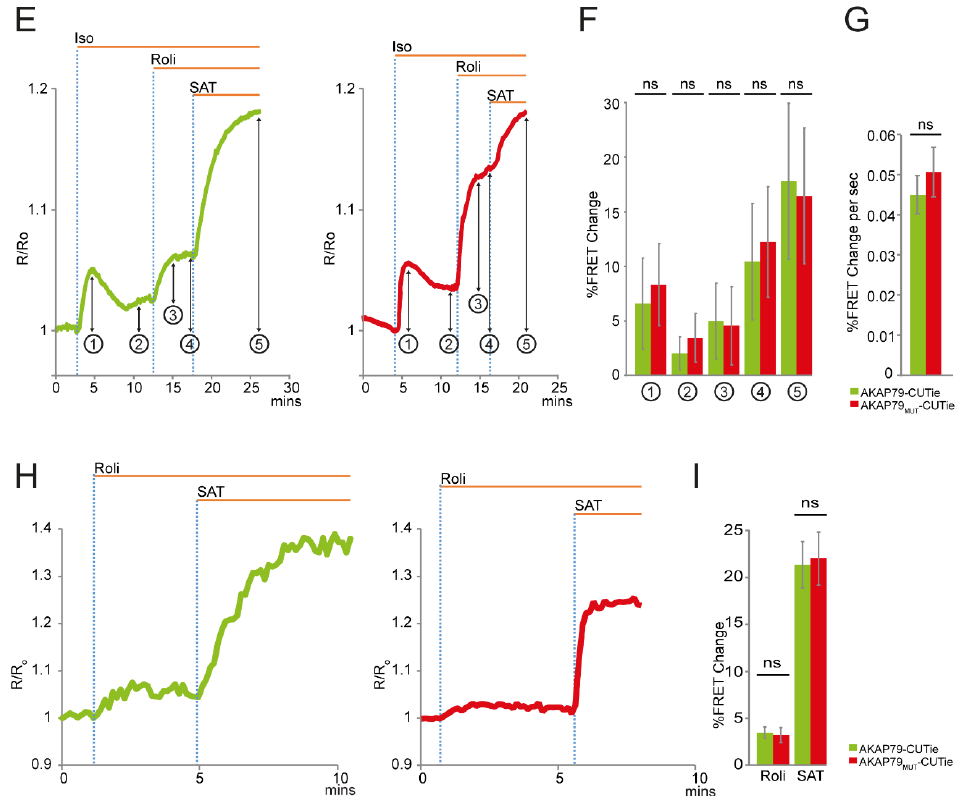
Figure 1. Effect on 3′–5′cyclic AMP (cAMP) readouts by using A-kinase anchoring protein 79 (AKAP79) as a targeting domain for CUTie. ( A ) Schematic representation of the targeted CUTie sensor. Stars represent the region where the mutations were introduced in AKAP79 Mut -CUTie. CNBD is cyclic nucleotide binding domain, CFP is cyan fluorescent protein, and YFP is yellow fluorescent protein; ( B ) Confocal images showing the predominant localization of AKAP79-CUTie and AKAP79 Mut -CUTie at the plasmalemma of neonatal rat ventricular myocytes (NRVMs). Scale bar is 10 μm; ( C ) Western blot analysis showing co-immunoprecipitation of protein kinase A (PKA) RIIα with AKAP79-CUTie and not with AKAP79 Mut -CUTie. CUTie, the untargeted cytosolic version of the cAMP sensor [9], was used as the control. WCL indicates whole cell lysate; ( D ) Western blot analysis showing co-immunoprecipitation of AKAP79 Mut -CUTie and AC5/6. Ctrl bead indicates pulldown with beads without the GFP-trap_A; Representative kinetics ( E ) and summary ( F ) of fluorescence resonance energy transfer (FRET) change on application of 0.5 nM Isoproterenol (Iso) followed by 10 μM Rolipram (Roli) in NRVMs expressing AKAP79-CUTie (green) and AKAP79 Mut -CUTie (red), respectively. Bars in F were calculated as relative increase as indicated by the corresponding arrows in E : ① is Iso maximal response; ② is Iso plateau; ③ is Roli after Iso plateau; ④ is Roli over basal; and ⑤ is saturating stimulus (SAT) of 25 μM forskolin + 100 μM IBMX; ( G ) Summary of the rate of FRET change on application of Iso 0.5 nM; Representative kinetics ( H ) and summary ( I ) of FRET change on application of Rolipram (Roli) 10 μM in absence of β-adrenergic receptors (β-AR) stimulation in NRVMs expressing AKAP79-CUTie (green) and AKAP79 Mut -CUTie (red), respectively. SAT indicates application of saturating stimulus (25 μM forskolin + 100 μM IBMX). Statistical significance was assessed using one-way ANOVA with post hoc correction test except for G, where Student’s t -test was used. For all experimental sets, data is presented as mean ± s.e.m. For all experimental sets n ≥ 15 from at least three biological replicates (independent myocyte isolations). In order to determine whether the anchoring of PKA to AKAP79 may affect the amplitude and kinetics of the local cAMP signal, NRVMs expressing either AKAP79-CUTie or AKAP79 Mut -CUTie were treated with the β-adrenergic agonist isoproterenol (Iso, 0.5 nM). A transient FRET change on